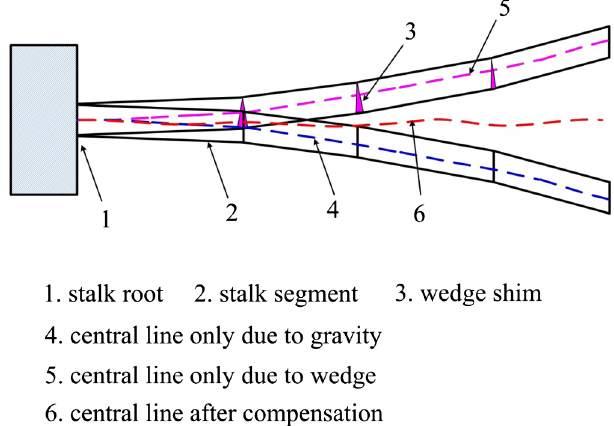
FIG. 11. Principle of deflection compensating of the cantilever tube. The blue line (4) represents the central line of the cantilever when only gravity induced deflection is considered. The magenta line (5) represents the central line of the cantilever when wedge shims are introduced between segments. The red line (6) repre- sents the final central line when the overall effect of gravity and wedge shims is considered.FIG. 9. Stress distribution computation and analysis when